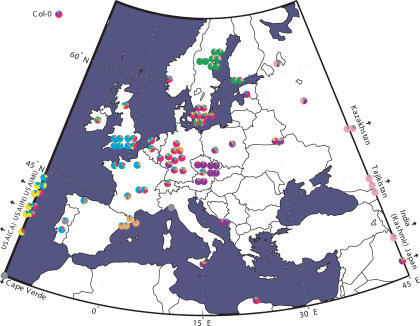
The global geographic structure of variation in Arabidopsis is shown by the clusters of similar pie charts signifying patterns of isolation (each chart represents an Arabidopsis accession)